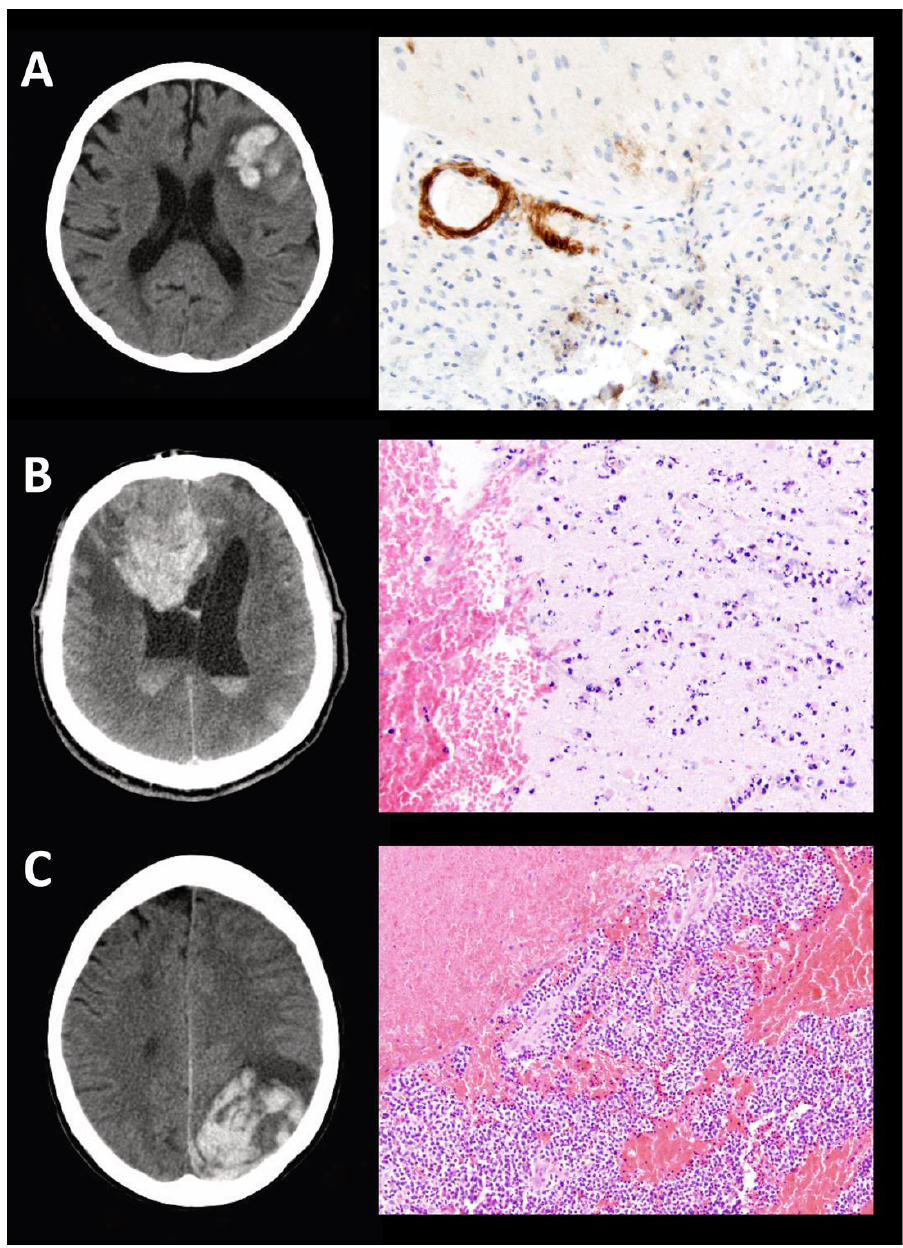
Figure 3. Exemplary cases with histopathological work-up for lobar ICH. ( A ) Lobar ICH accompa- nied with underlying CAA; ( B ) Lobar ICH accompanied with phlegmonic granulocytic infiltrates; ( C ) Lobar ICH caused by anaplastic oligodendroglioma; original magnification: ( A / B ) 200× (ocular lens 10×, objective lens 20×, NA 0.50), (( C ) 100× (ocular lens 10×, objective lens 10×, NA 0.30).